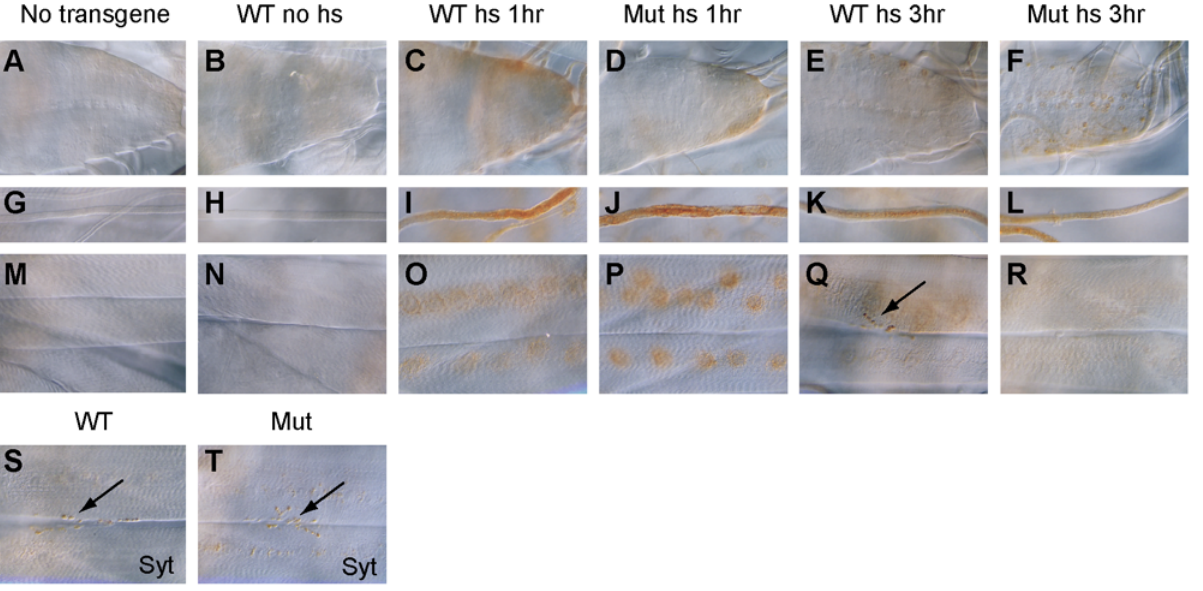
Figure 6. Impaired subcellular localization of exogenously expressed APPL-FLAG in the yata mutant motor neurons. (A–R) Third instar larval ventral ganglion (A–F), axons (G–L) and muscles 6 and 7 of the abdominal segments (M–R) were stained with anti-FLAG antibody. Examined larvae were w (A, G, M), w ; hs-APPL-FLAG/ + (B, H, N: no heat shock; C, I, O; 1 hour; E, K, Q: 3 hours) and w ; hs-APPL-FLAG/ + ; yata KE2.1 /yata KE2.1 (D, J, P: 1 hour; F, L, R: 3 hours). In wild-type larva, APPL-FLAG was transported to the neuromuscular synapses at 3 hours after heat shock (arrow in Q). However, in yata mutant, synapses were not stained significantly. (R). Synaptic boutons were present in yata mutant (arrow in T) similar to the wild type (arrow in S), as was revealed by staining with anti-Synaptotagmin I